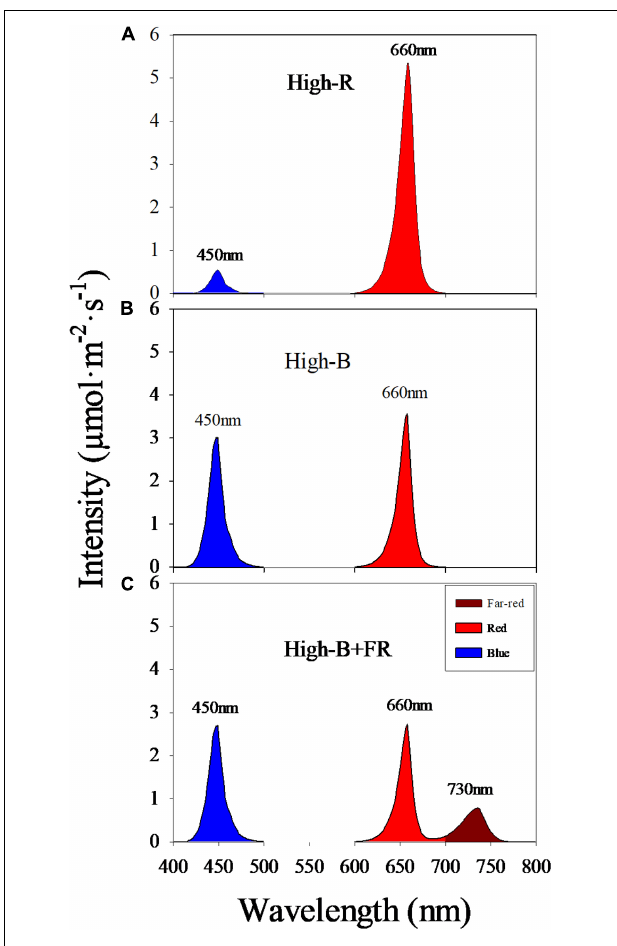
FIGURE 2 | Spectral composition in different light treatments: (A) red: blue: far-red = 90: 10: 0 (“High-R”), (B) red: blue: far-red = 50: 50: 0 (“High-B”), and (C) red: blue: far-red = 42: 42: 16 (“High-B+FR”). Peak wavelength numbers are shown for each